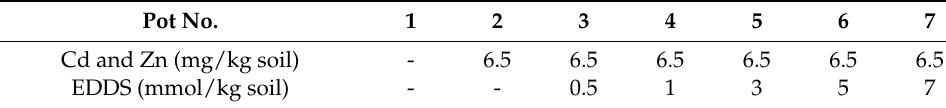
Table 1. Conditions of the pot experiments. Pot No. 1 Cd and Zn (mg/kg soil) - EDDS (mmol/kg soil) - -